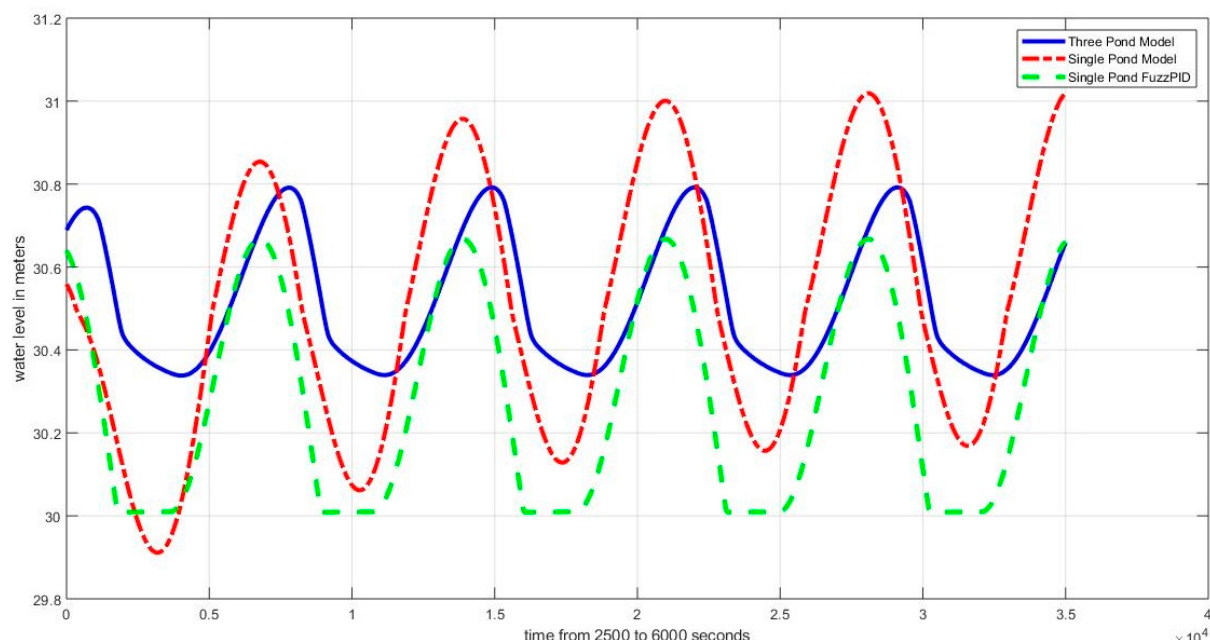
Figure 13. Traditional system (Fuzzy and FuzzyPID) and the proposed system (sinusoidal dis- turbance).